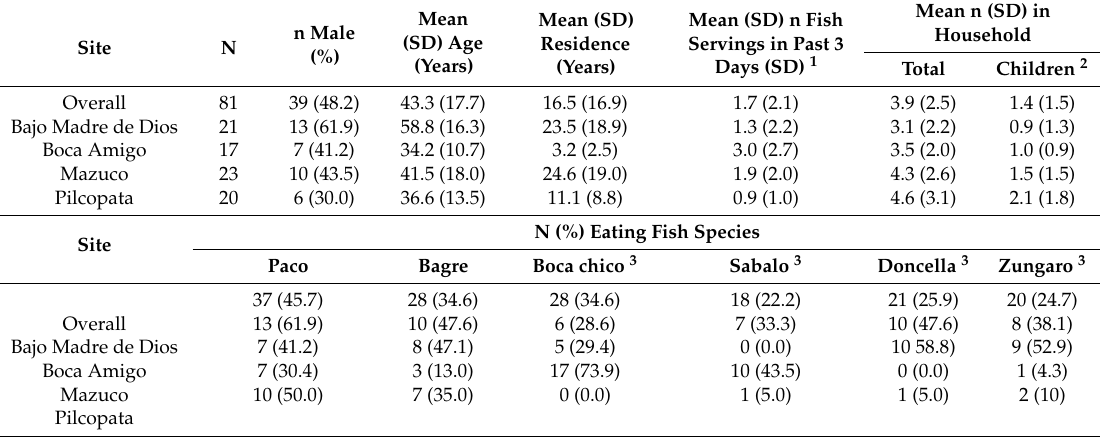
Table 3. Demographic characteristics of 81 human participants at four study sites in the Madre de Dios river basin of Southeastern Peru.